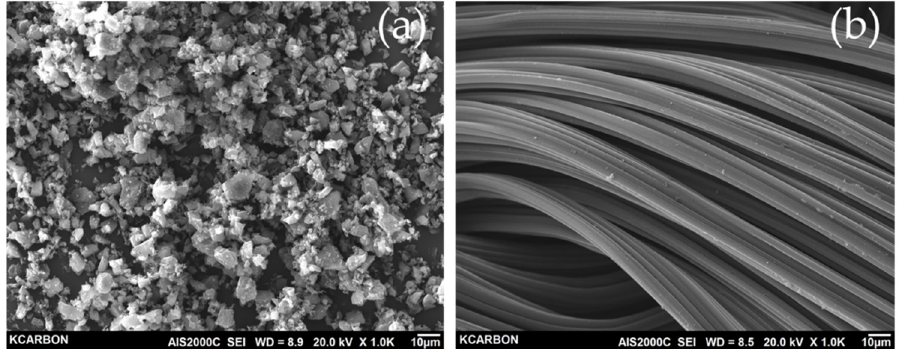
Figure 2. Structural characteristics of RACF as a function of various steam activation conditions.